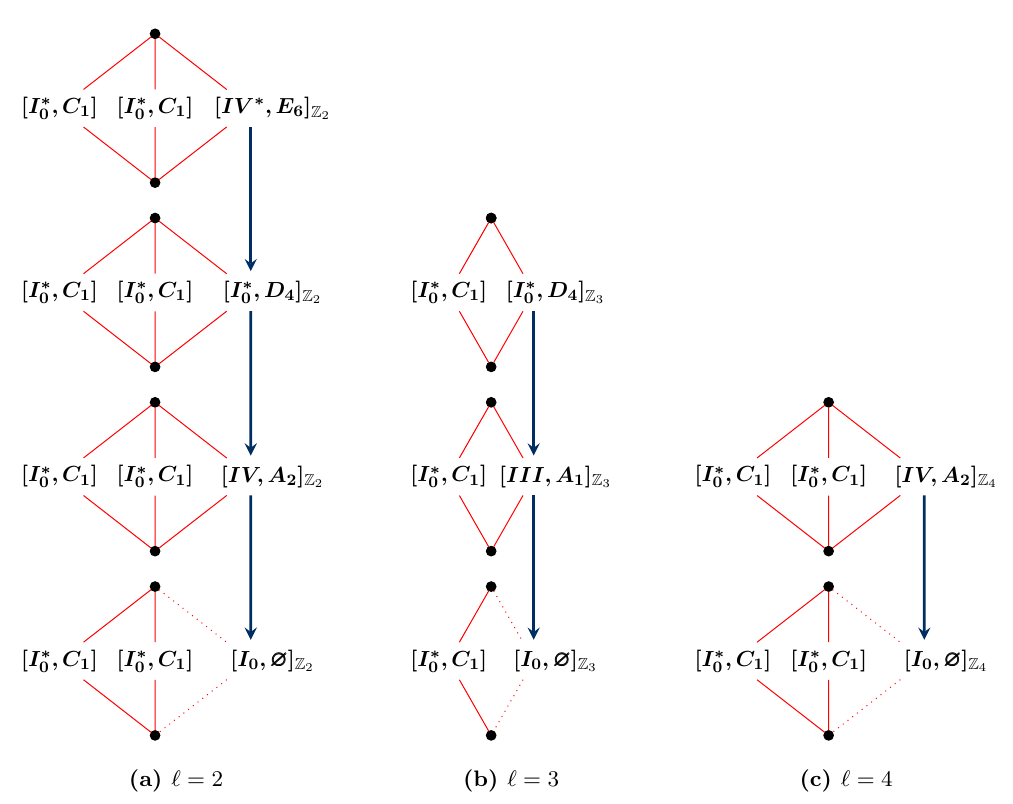
Figure 10. F-theory mass deformations of the T (2) K(cid:127)ahler strati(cid:12)cation; (a) is for ‘ = 2, (b) is for ‘ = 3 and (c) is for ‘ =